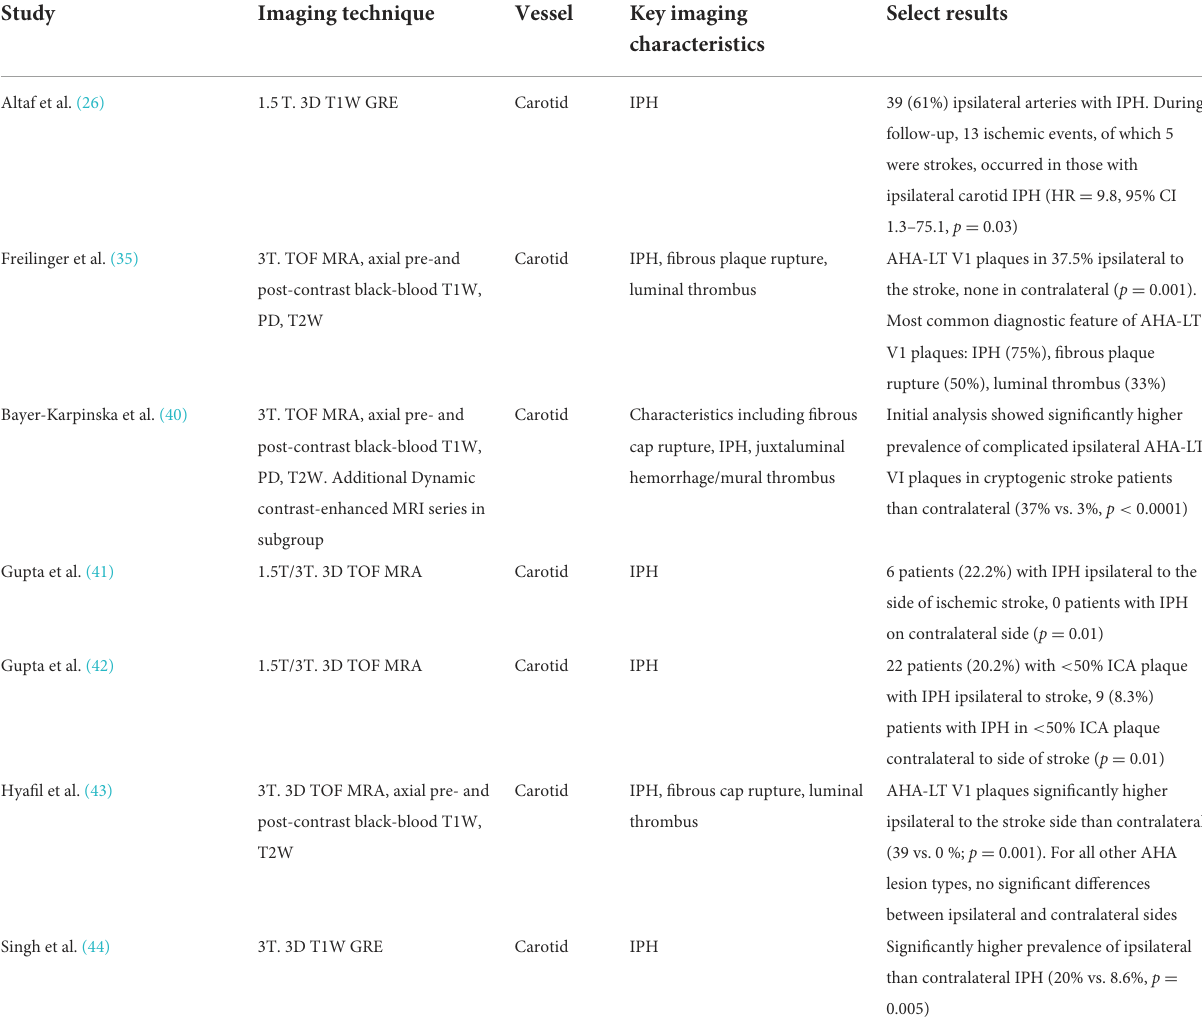
TABLE 1 Select studies using VW-MRI in an ESUS/CS population for evaluation of carotid